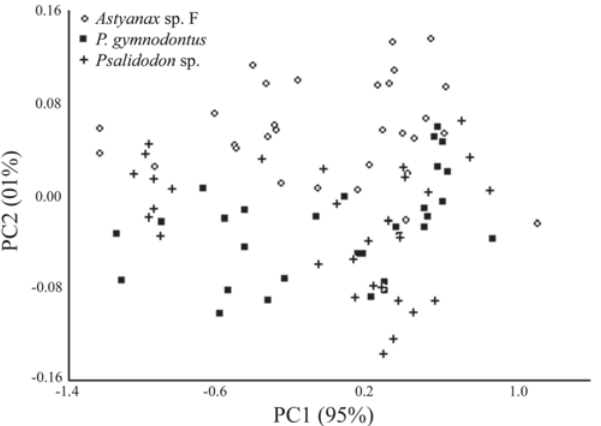
Fig. 2. Plots of scores obtained by principal components analysis of all measurements from the three